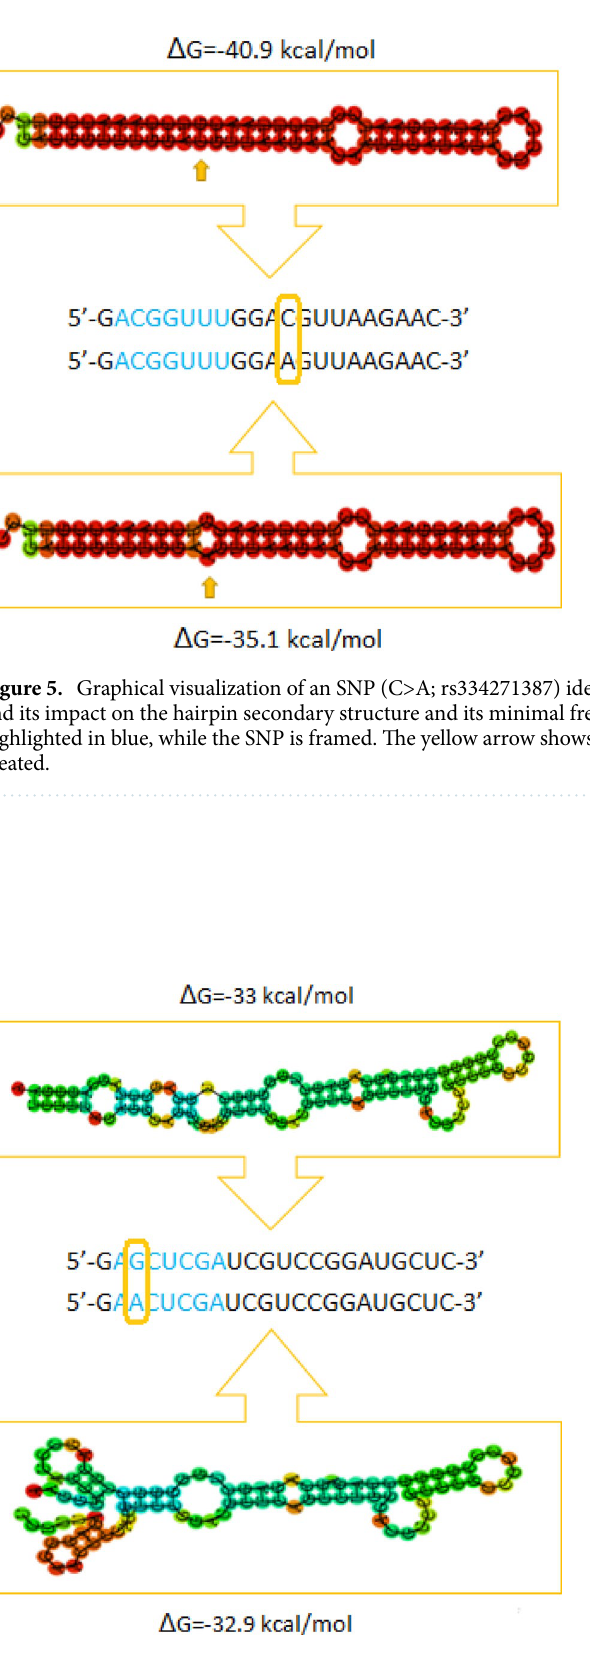
Figure 6. Graphical visualization of an SNP (G>A) identified in the seed region of ssc-miR-9819-5p and its impact on the hairpin secondary structure and its minimal free energy (MFE; ΔG). The seed region is highlighted in blue, while the SNP is